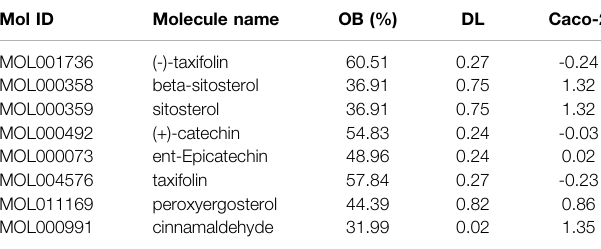
TABLE 1 | The main active compounds of Guizhi.